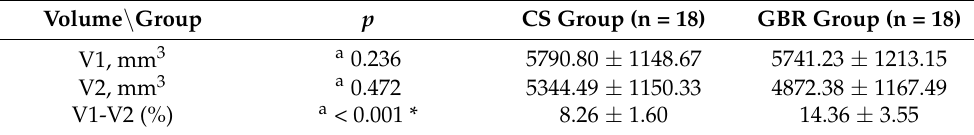
Table 3. Relationship between augmentation technique and bone graft resorption variable. Volume \